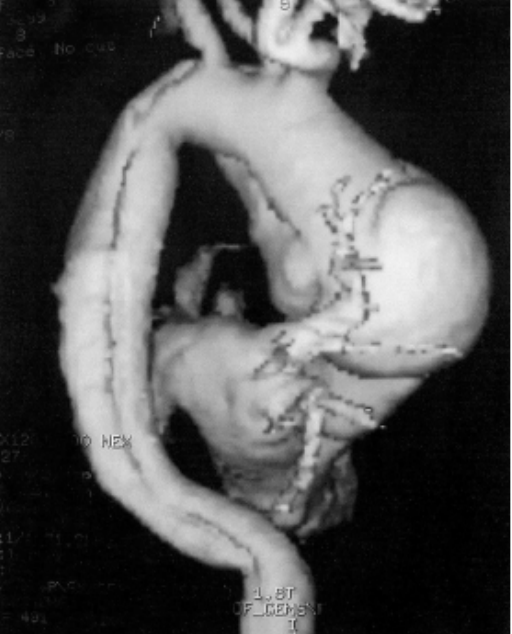
Fig. 1 - Magnetic angioresonance of the dissecting aneurysm of the ascending aorta, aortic arch and descending aorta.